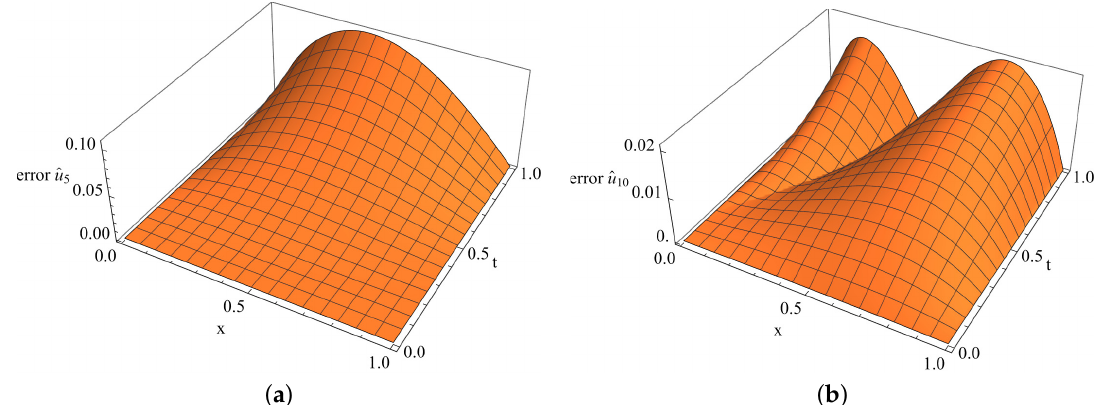
Figure 2. The exact solution u e ( a ) and the approximated solution (cid:98) u 10 ( b ).